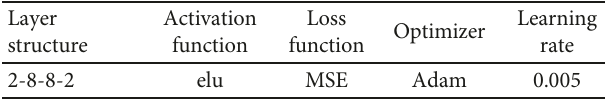
Table 2: Hyperparameter con fi guration of the basic model: nonrational nonpolynomial